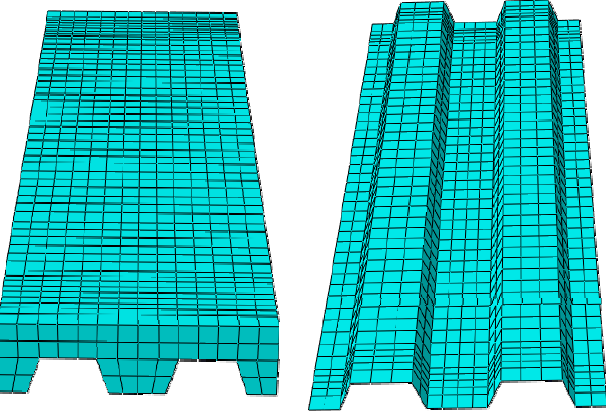
Figure 16. Finite element model.